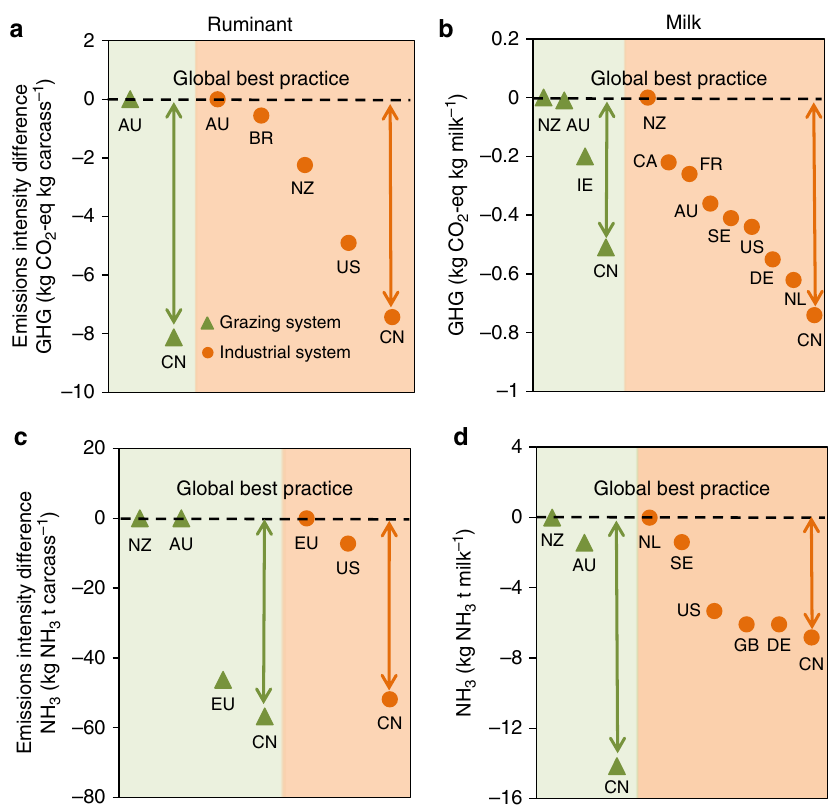
Fig. 2 Emissions intensity de fi cit among the nations. The emissions intensities of GHG ( a , b ) and NH 3 ( c , d ) for ruminant meat and milk vary across global production systems (grazing: orange circles; industrial: green triangles). The emissions intensities in China are much higher than global best-practice (the emissions intensity difference in local production ef fi ciency). The data are compiled from literature survey (Supplementary Tables 38-39). For nation